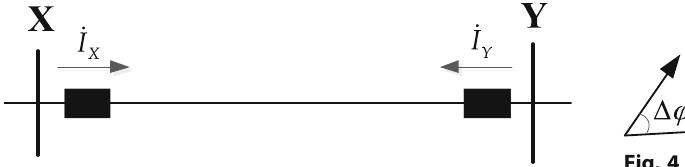
Fig. 3 Current direction of a simplified line